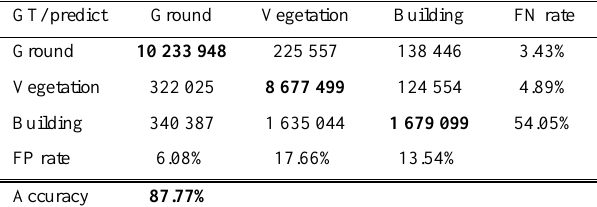
Table 4. Model 2 results for the AHN3 test set. Note the